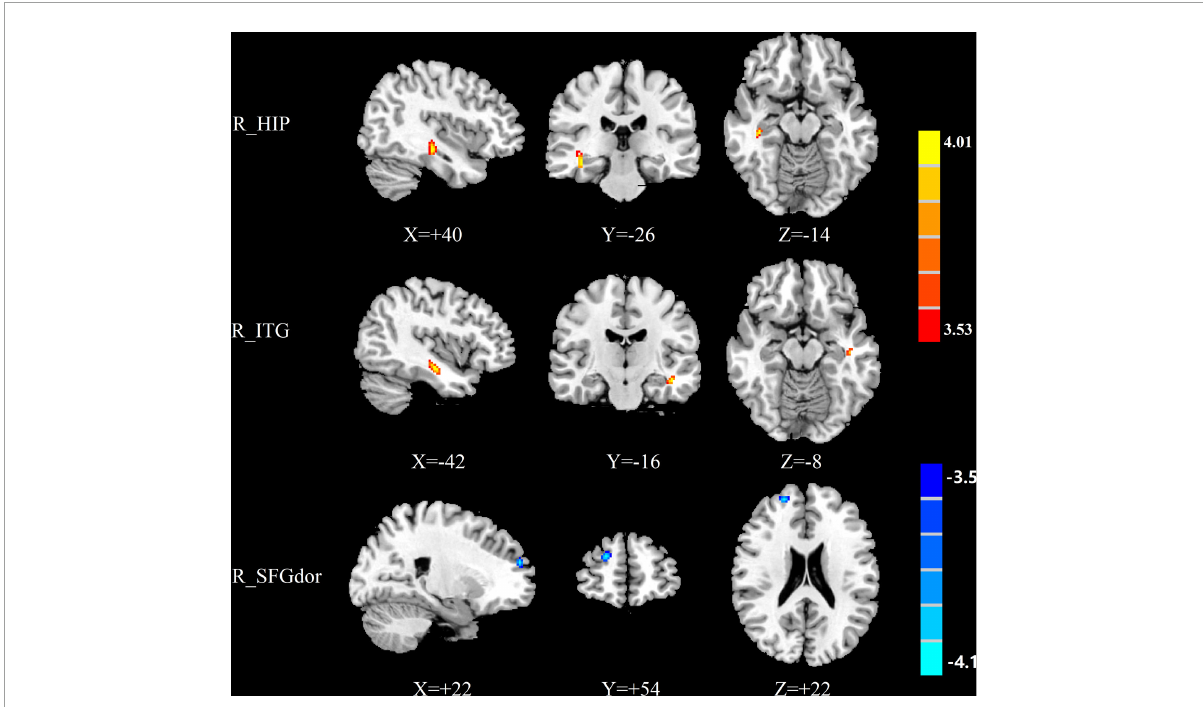
FIGURE2 Brain regions showing significant differences in normalized CBF between women patients and women controls. The warm color represents the significantly increased CBF in the women patients. The cold color indicates that the CBF was significantly decreased in the women patients. CBF, cerebral blood flow; R, right; HIP, hippocampus; ITG, inferior temporal gyrus; SFGdor, superior frontal gyrus, dorsolateral.